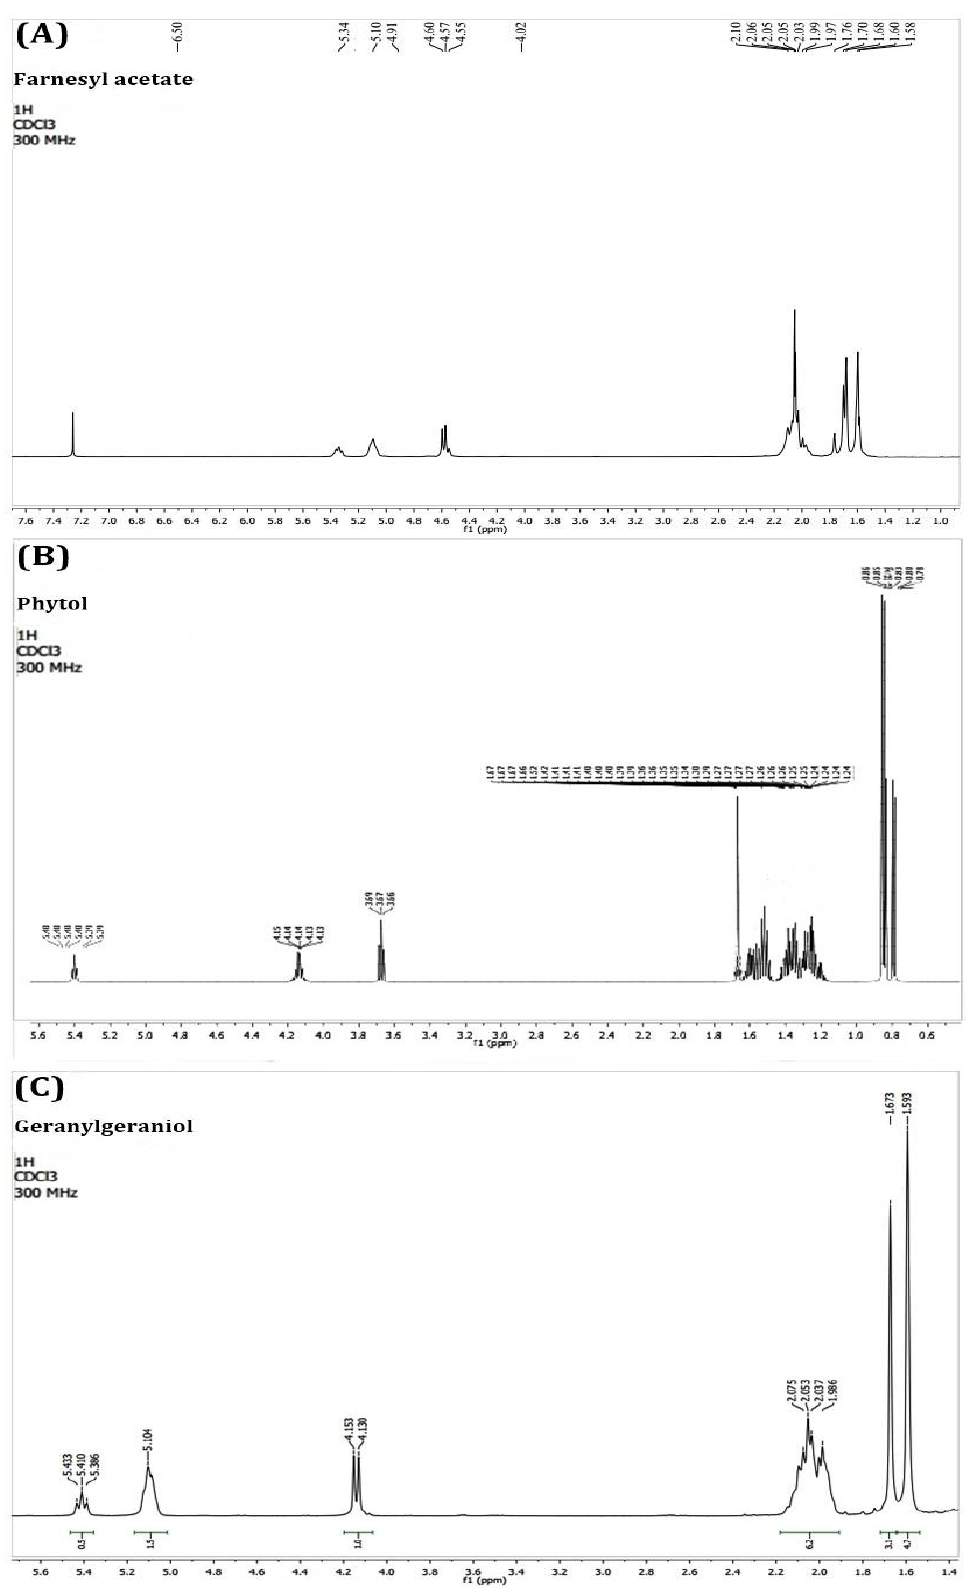
Figure 4. 1 H-NMR spectra of acyclic terpenoids farnesyl acetate ( A ), phytol ( B ) and geranylgeraniol ( C ).